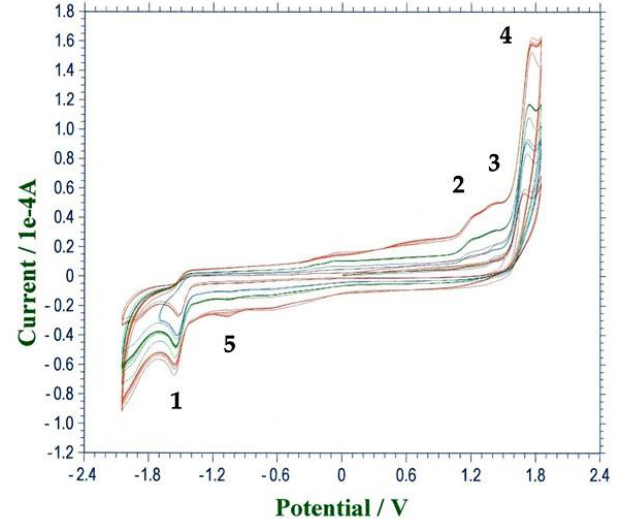
Figure 3. CV responses of HMF (1 mmol dm −3 ) in a 0.1 mol dm −3 of LiClO 4 in methanol. WE: GC; AE: Pt; RE: SCE, potential scan rate: 0.10 V s −1 , red line; 0.30 V s −1 , blue line, 0.50 V s −1 , green line; 1.0 V s −1 , brown line.